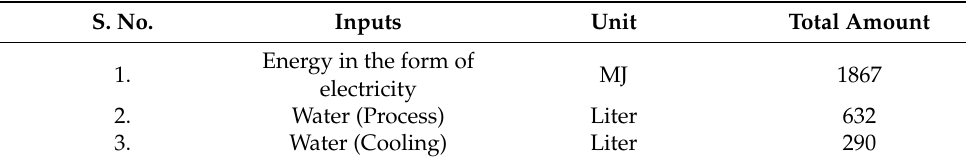
Table 2. List of inputs for remanufacturing [15]. S. No. Inputs Unit Total Amount Energy in the form of 1. MJ 1867 electricity 2. Water (Process) Liter 632 3. Water (Cooling) Liter